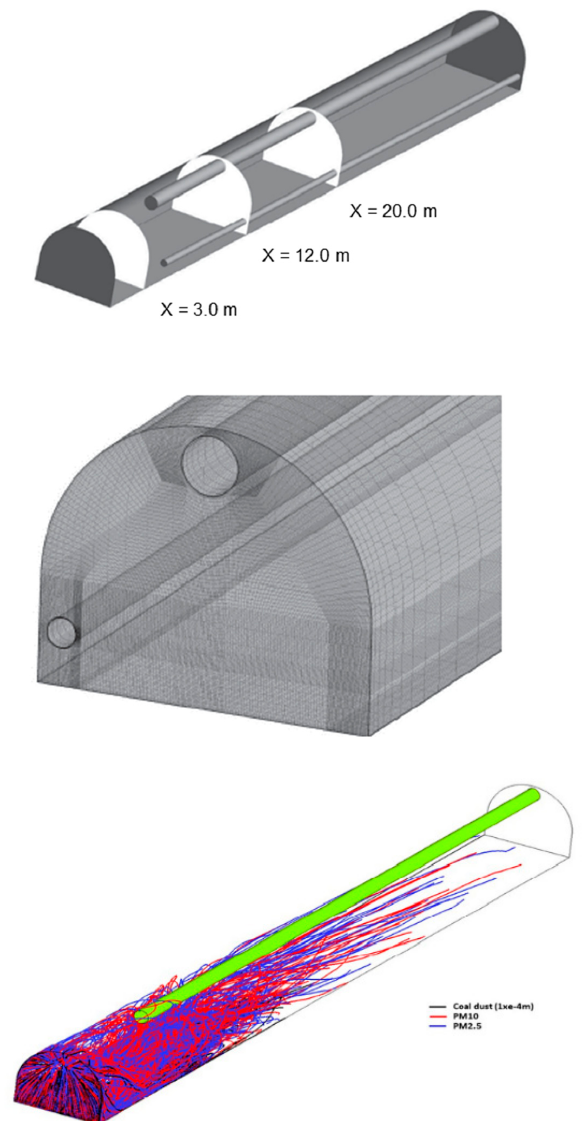
Figure 1. CFD modeling procedures: geometry building, grid generation, solving, and post-processing [10]. (Adapted with permission from ref. [10]. Copyright 2020 Springer Nature Switzerland AG).